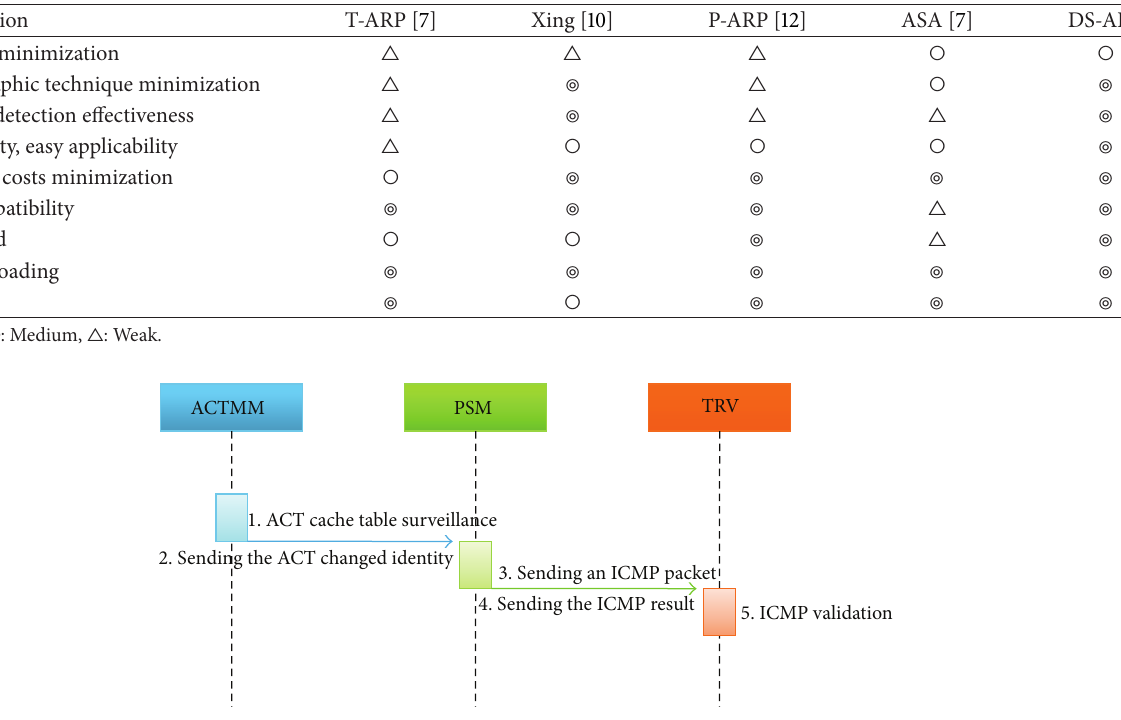
Table 2: Comparisons of current schemes versus the proposed scheme.